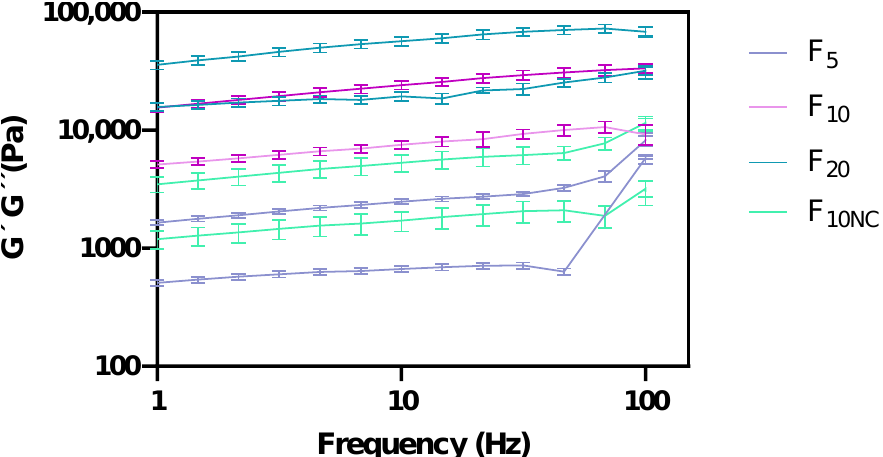
Figure 5. Effect of glycerol monostearate content (F 5 , F 10 and F 20 ) and homogenization rate (F 10NC ) on the formulation frequency sweep.